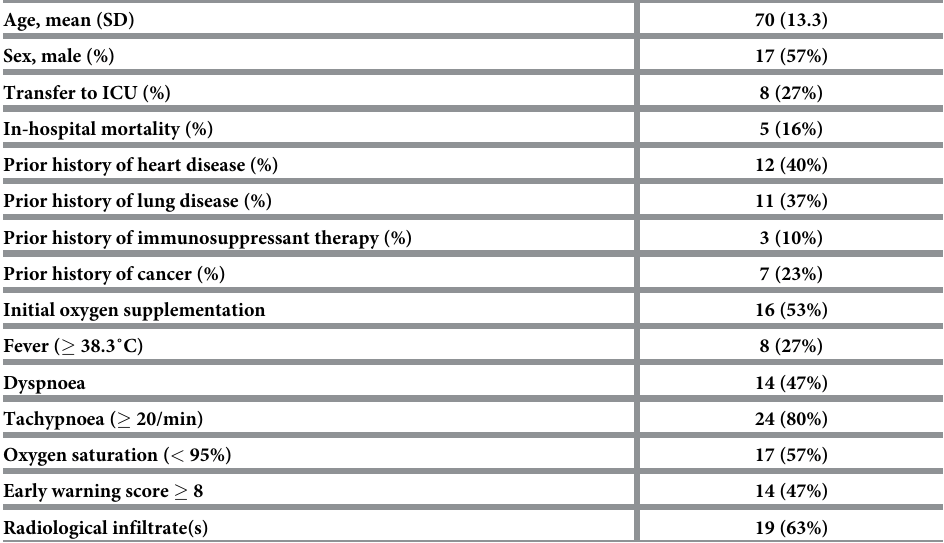
Table 1. Patient demographics and clinical baseline